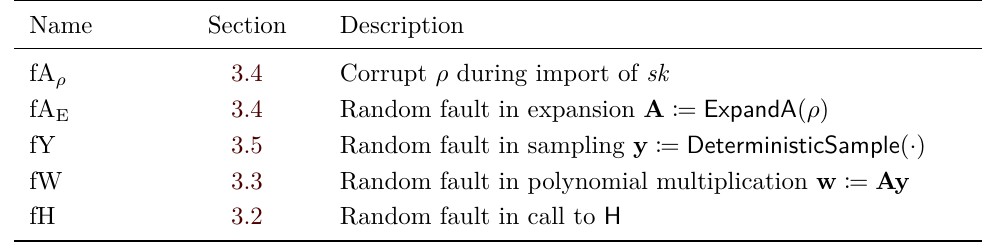
Table 2: Fault scenarios discussed in this paper